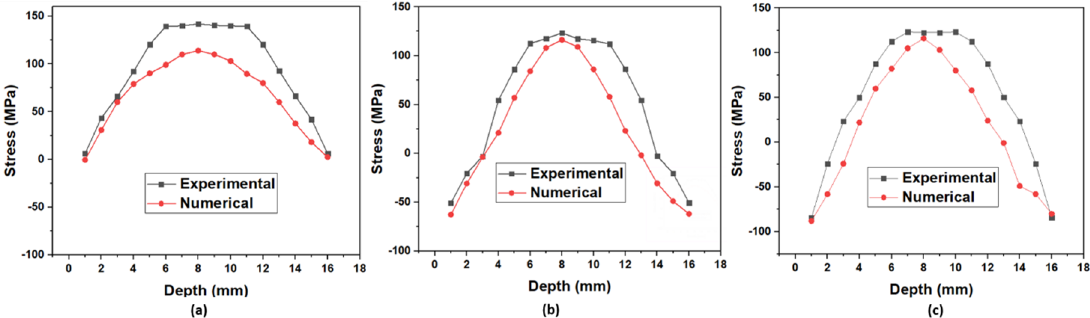
Figure 12. Kernel average misorientation (KAM) images of ( a ) 0.7 m / min, ( b ) 1.25 m / min and ( c ) 2 m / min of the 25% swaged (surface).